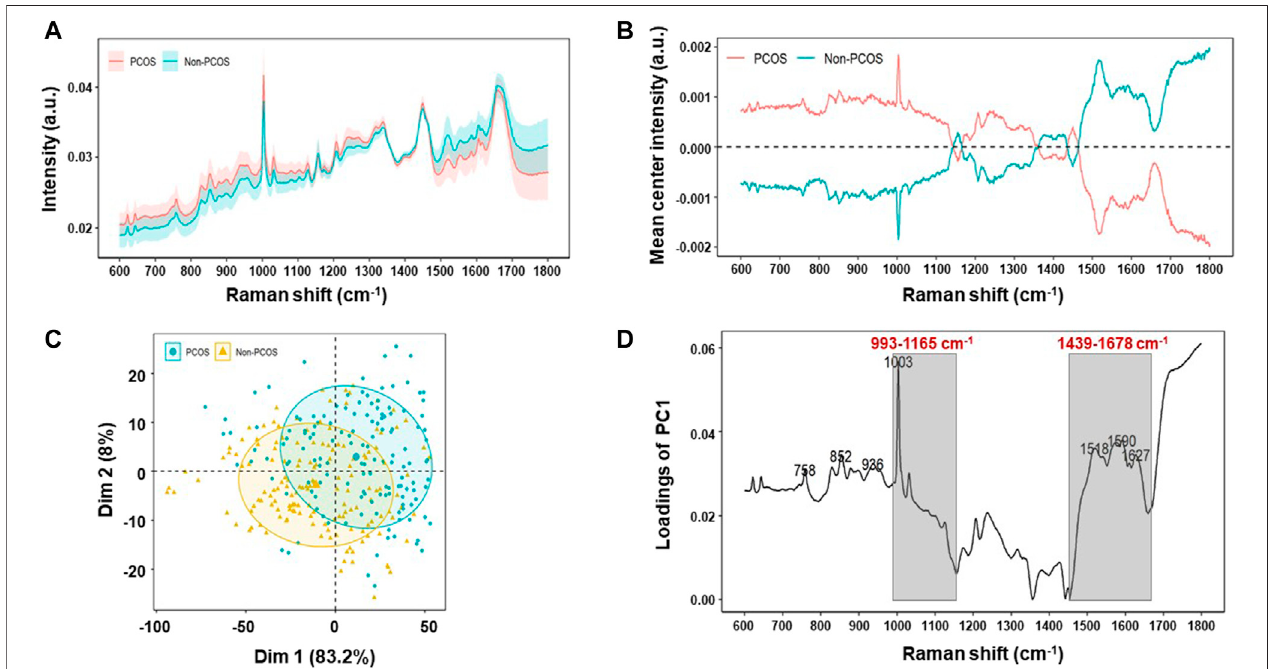
FIGURE 2 | Raman pro fi ling of follicular fl uid of PCOS and non-PCOS. (A) Averaged Raman spectra of follicular fl uid of PCOS ( n (cid:1) 150) and non-PCOS ( n (cid:1) 150) patients.Shadedareasrepresentthestandarddeviations. (B) Mean-centeredRamanspectradifferencesbetweenPCOSandnon-PCOSgroupsbysubtractingmeans fromallsamples. (C) Principalcomponentanalysis(PCA)ofallRamanSpectratoshowtheclusteringofPCOS andnon-PCOSgroups. (D) Ramanwavenumber loading plots of contributions along dimension 1 of the PCA, where grey boxes indicate the two Raman zones responsible for the most signi fi cant variances between the two groups by comparing the quanti fi ed spectral intensity values.